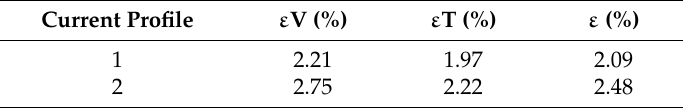
Table 4. Simulation